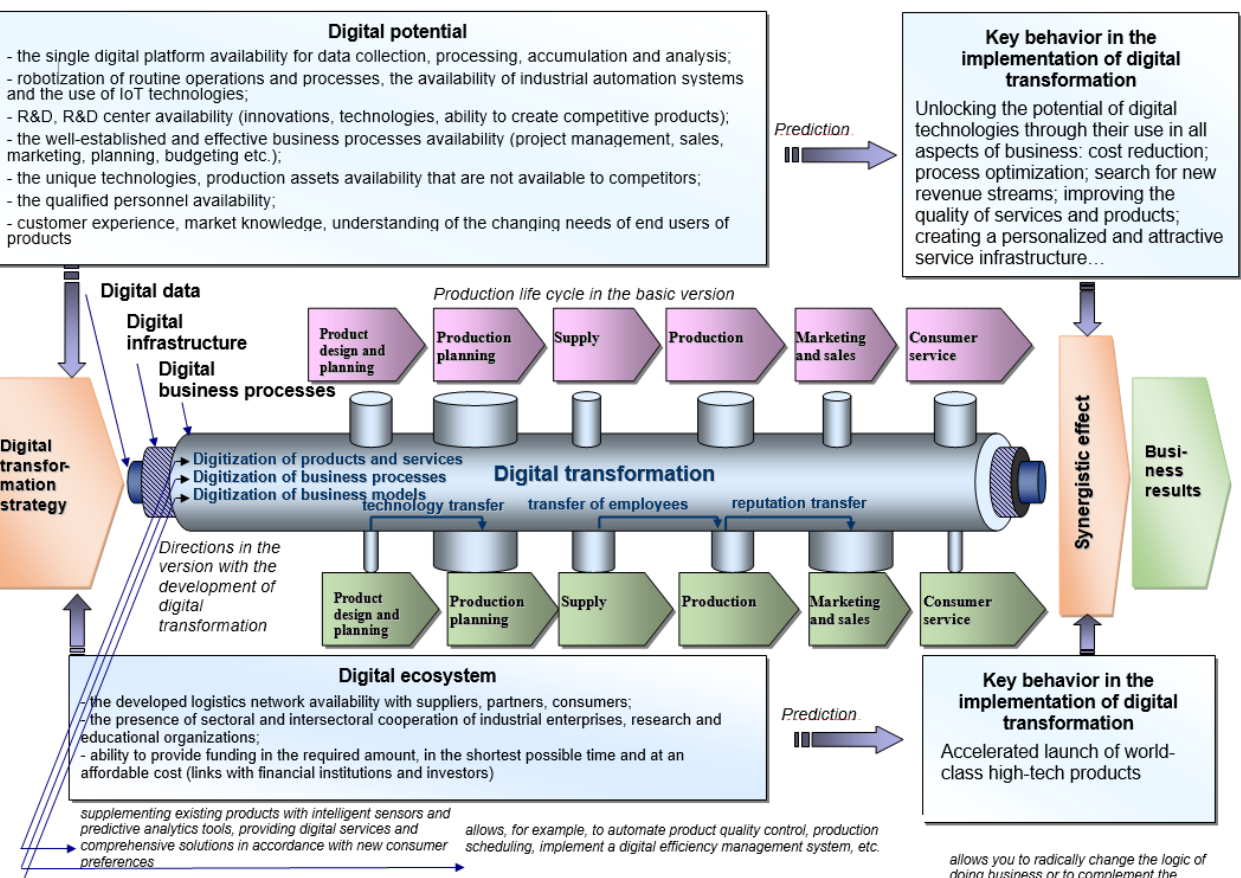
Figure 2. Concept of high-tech enterprise development management in the context of digital transformation. Source: own study.